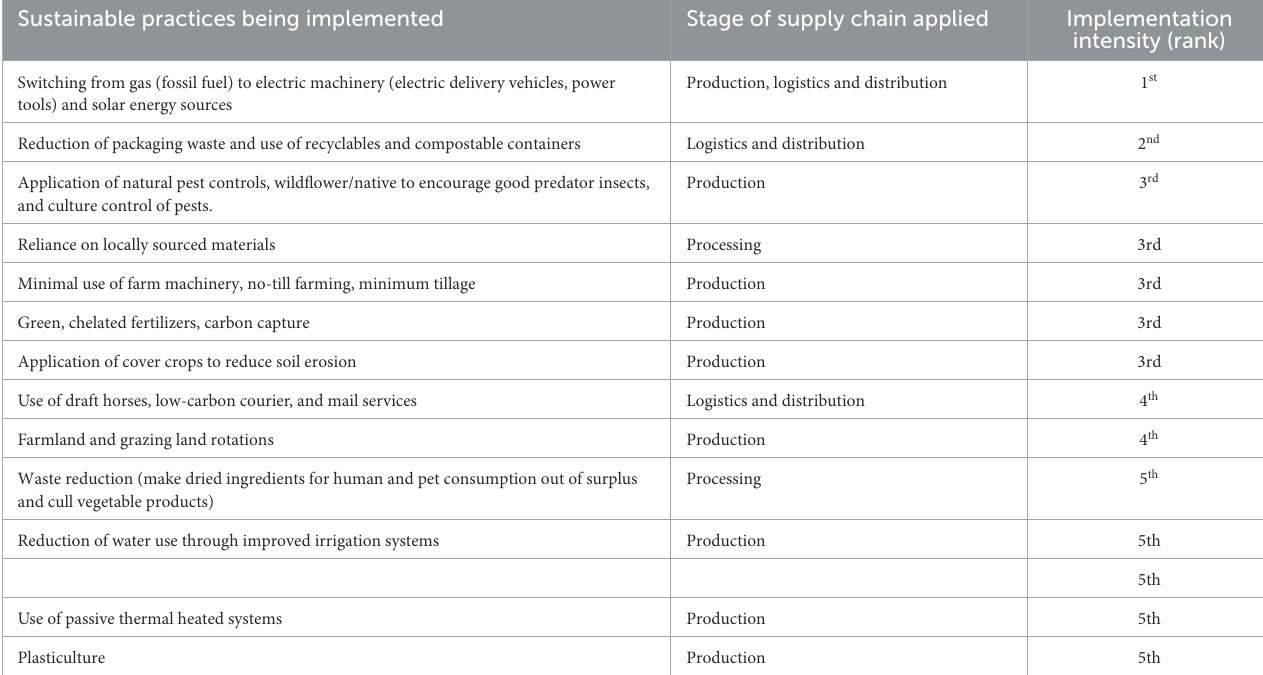
TABLE 6 Current sustainable practices in Atlantic Canada SFSCs.